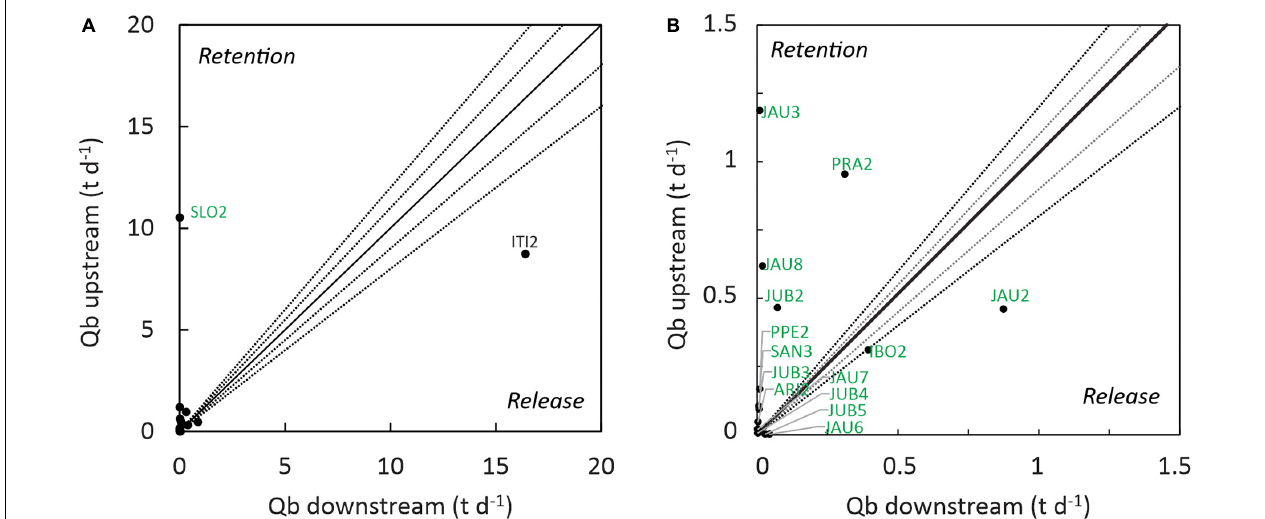
FIGURE 6 | Comparisons of changes in bedload sediment transport between upstream and downstream of current hydroelectric facilities based on primary data collected in this study. (A) All data; (B) the same data with high values excluded. Solid line shows the line of parity and dashed lines show bounds of ± 10 and ± 20% around that line; points above the line indicate net retention and those below indicate net release between the upstream and downstream sampling points. Upstream:downstream ratios that deviate considerably from 1:1 are identified with the codes shown in Table 1 ; codes in green font indicate cases where the statistical analysis of the changes across all individual sampling dates showed significant ( p < 0.05) differences from zero.